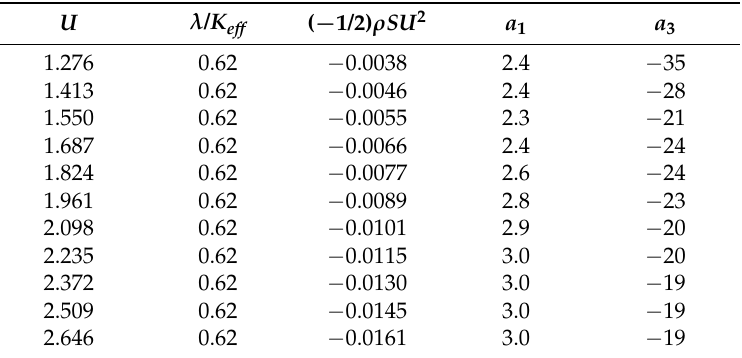
Table 1. Values of system aerodynamic parameters and a 1 , a 3 .